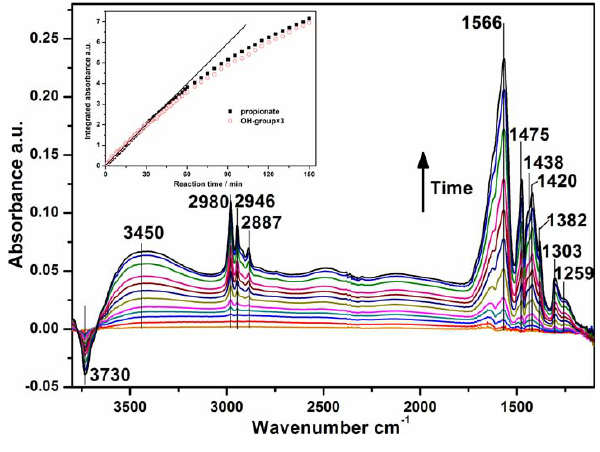
Fig. 3. Absorption spectra recorded during the reac- tion of CH 3 CH 2 COOH ([CH 3 CH 2 COOH] 0 =1.23 × 10 14 moleculescm − 3 ) on α -Al 2 O 3 particles. The inset shows the temporal evolution of the integrated absorbance of the propionate absorption band (1360–1510cm − 1 ) and the OH absorption band (3600–3800cm − 1